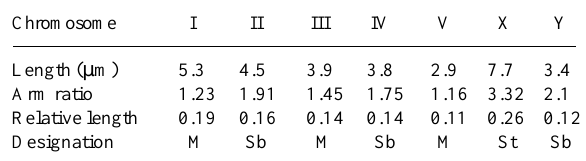
Table I - Analysis of the somatic complements of Pattonella intermutans . The relative length of Y was expressed as a function of the length of X. N =